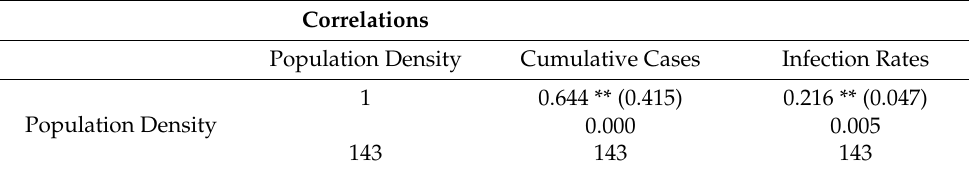
Table 6. Summary of the results from both analytical